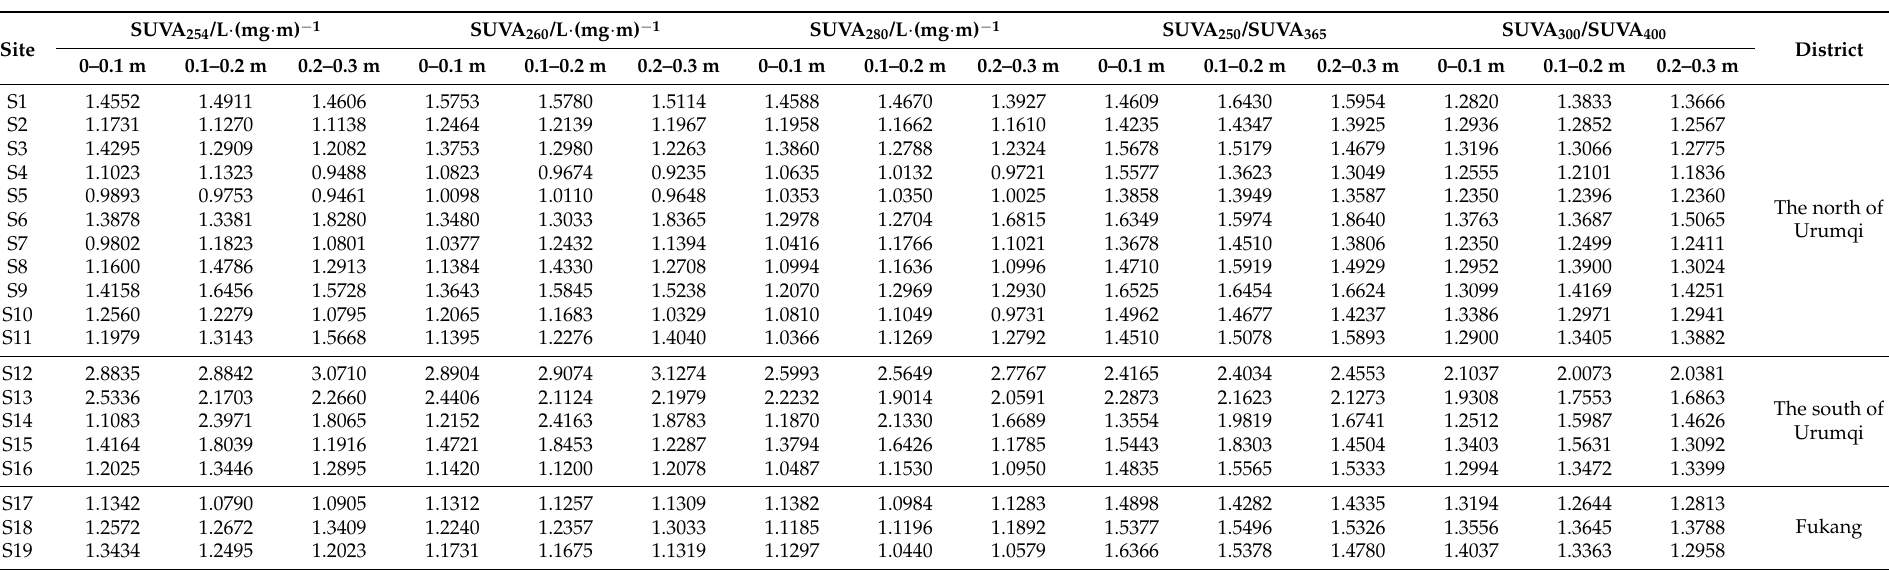
Table 2. The characteristics of UV spectra absorption of soil DOM on different districts (SUVA 254 , SUVA 260 , SUVA 280 , SUVA 250 /SUVA 365 , SUVA 300 /SUVA 400 ).